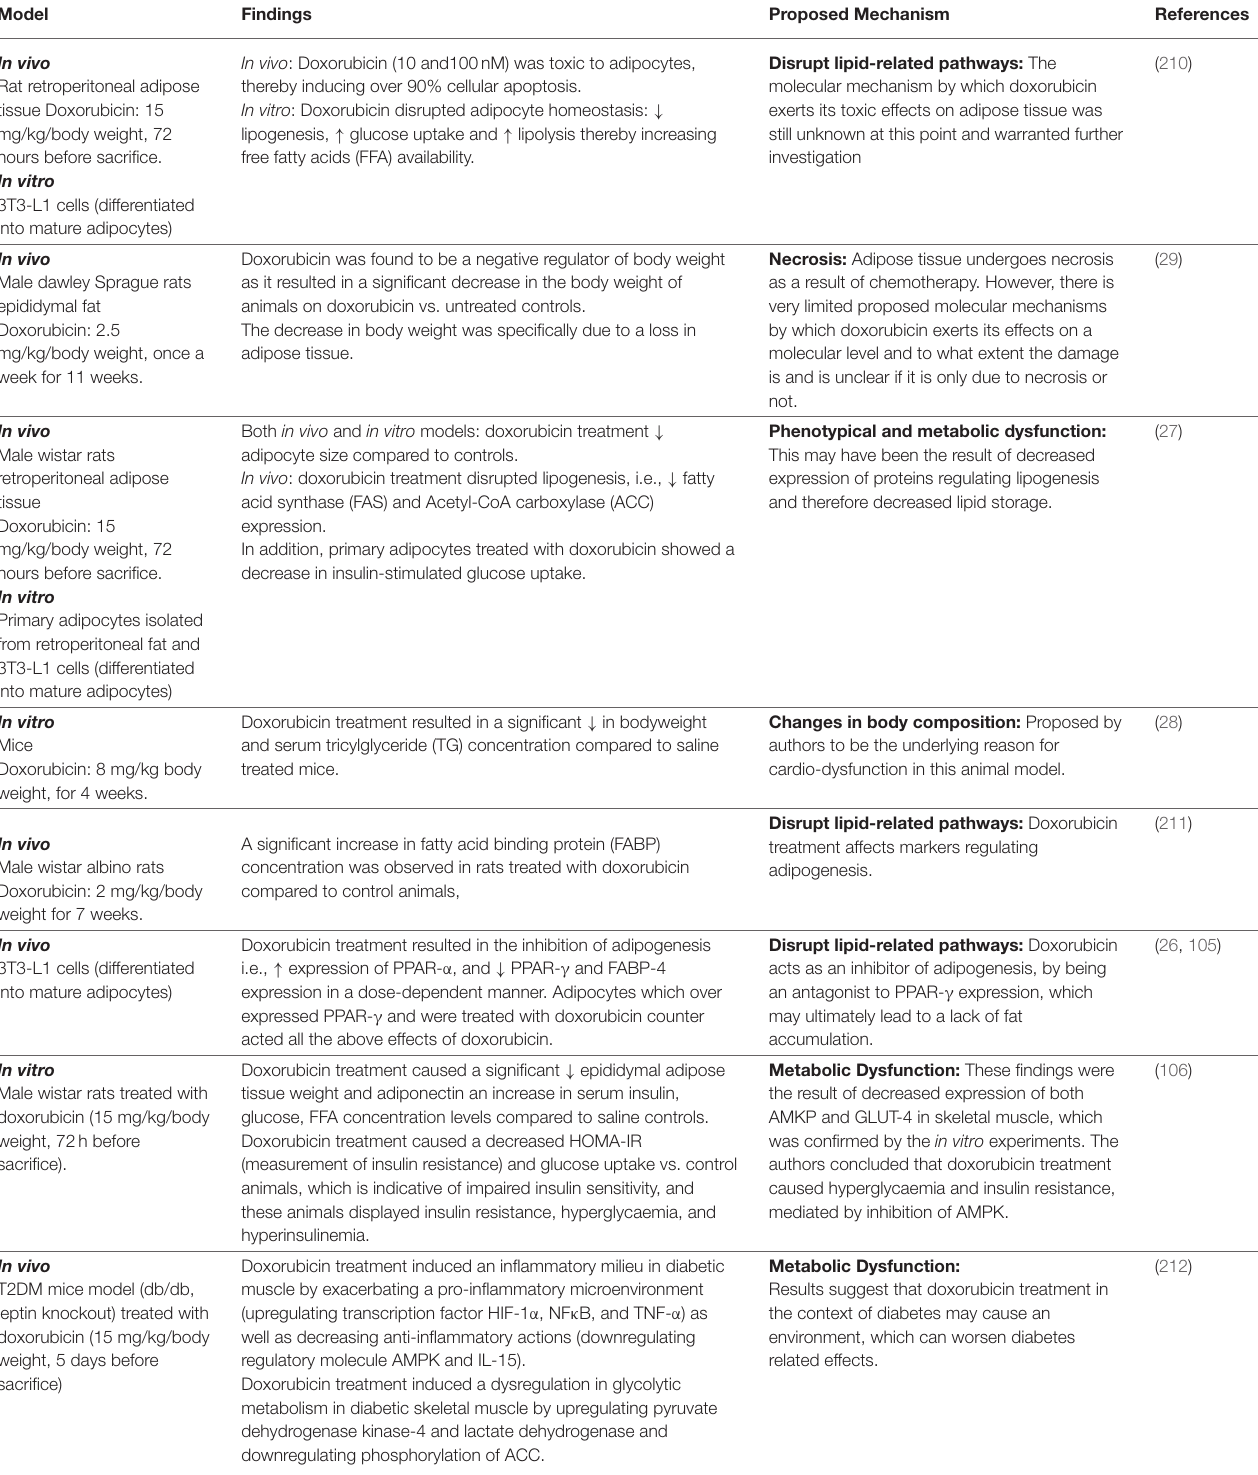
TABLE 1 | Effect of doxorubicin on adipose tissue and/or adipocytes.